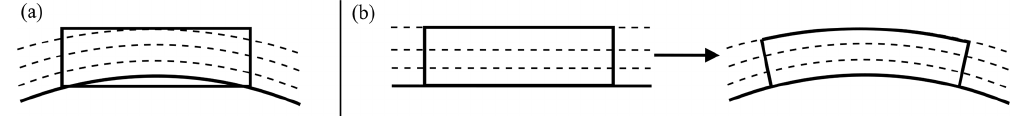
Figure 4. Schematic comparison of direct spherical-to-Cartesian transformation (a) and the inverse plate carrée projection (b) . The schematic shows a vertical cut through the atmosphere and Earth’s surface (solid arc). The solid boxes represent the PALM domain and dashed arcs indicate isosurfaces of Earth’s gravitational potential.